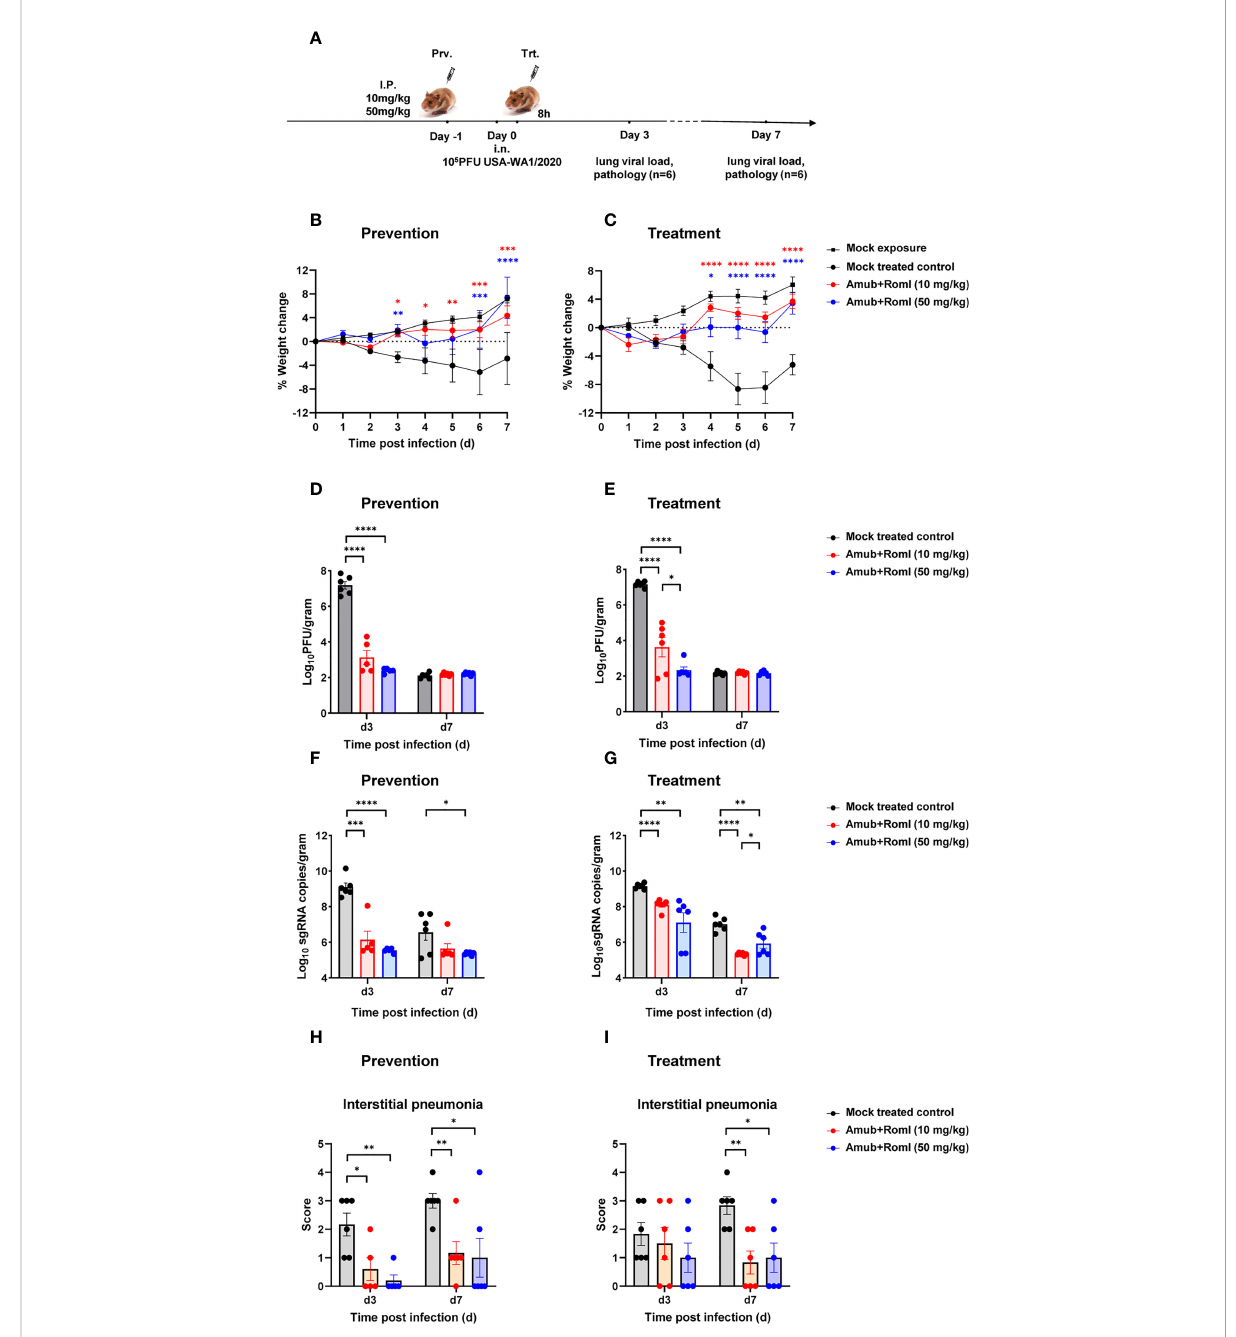
FIGURE 4 Amubarvimab and Romlusevimab together show in vivo ef fi cacy in a hamster model of SARS-CoV-2 infection. (A) Overview of in vivo study design. mAb or PBS was injected i.p. 24 hr before (B, D, F, H) or 8 hr after (C, E, G, I) intranasal challenge with 100,000 PFU live virus on day 0. (B, C) Body weigh change of Syrian hamsters relative to day 0. Animals were weighed daily, and the percent of weight change was plotted. Symbols represent mean ± standard error of the mean (SEM). (D, E) Viral burden re fl ected by PFU in the lung tissues. PFU was measured and normalized with weights. Bars represent the geometric means ± SEM in PFU per gram. (F, G) Viral burden re fl ected by subgenomic (sg) RNA of virus E gene in the lung tissues. Quantitative PCR was performed to measure the copies of sgRNA of virus E gene in lung tissue homogenates. The bars represent the geometric mean of subgenomic RNA copies per gram ± SEM. (H, I) Pathology scores of lung sections. A pathology score was assigned by board-certi fi ed veterinary pathologist based on histologic fi ndings on H&E-stained lung sections. Data are presented as mean + SEM. Signi fi cant differences relative to the comparative group using unpaired t-test are shown as asterisk: * p < 0.05, ** p < 0.01, *** p < 0.001, and **** p < 0.0001 (unpaired two-tailed Student ’ s t